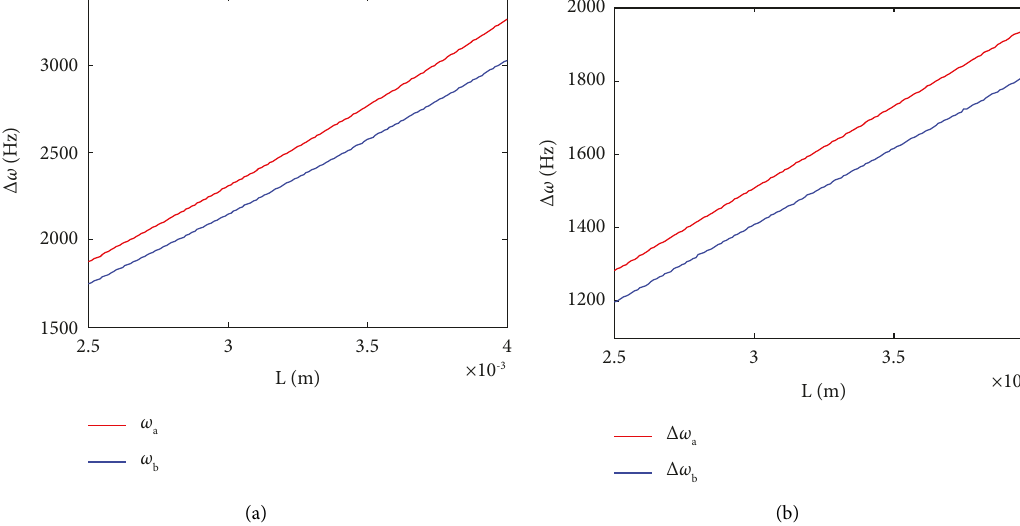
Figure 6: Effects of molecule force and resonator length on resonant frequency difference. (a) Odd. (b)